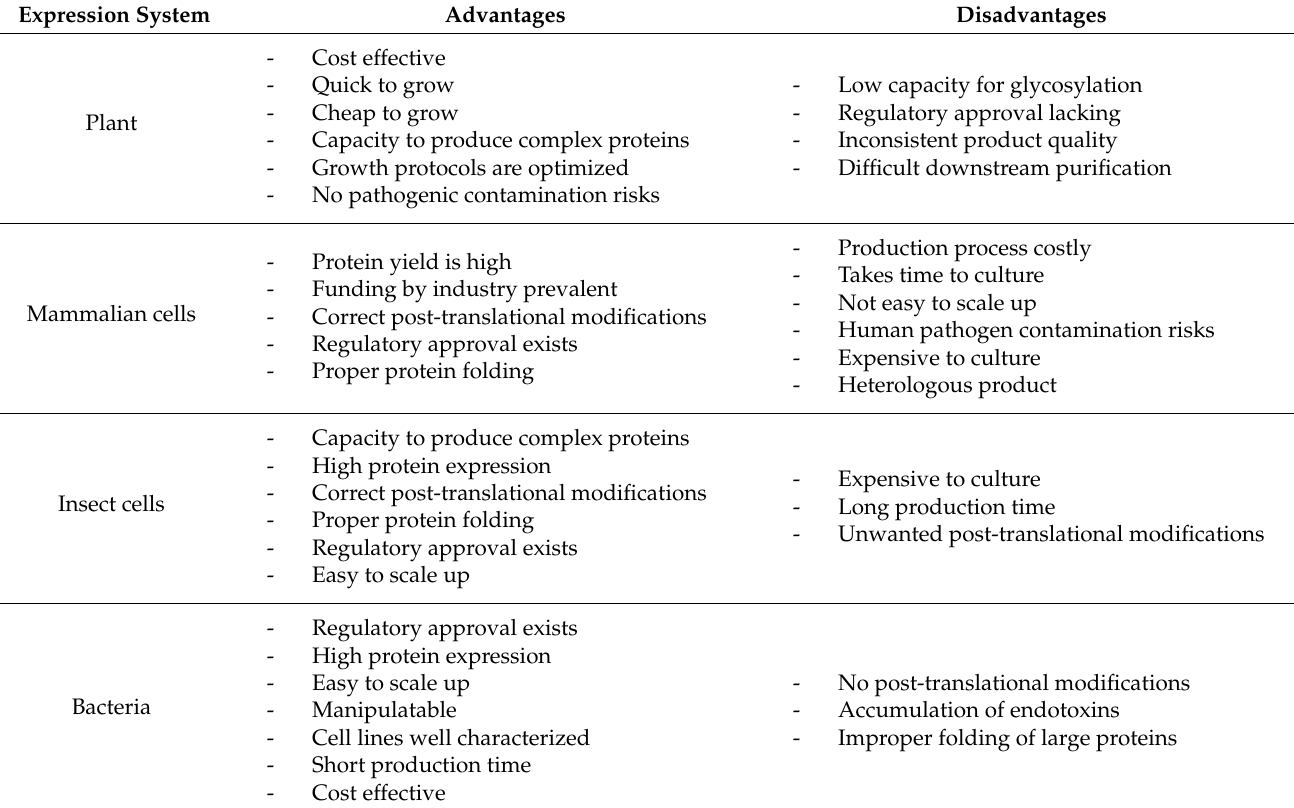
Table 2. Advantages and disadvantages of different expression systems used during recombinant protein production (Developed with guidance by